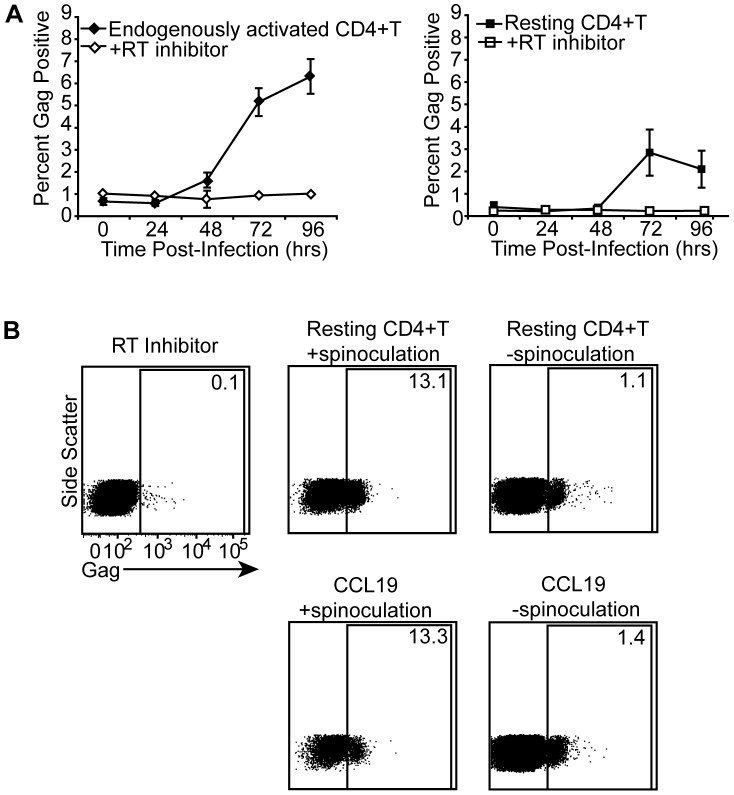
Infected resting CD4+T cells can produce HIV Gag.Bulk unstimulated CD4+T cells were spinoculated and cultured in the presence of the protease inhibitor, saquinavir. Gag protein was measured in the endogenously activated (HLA-DR+, CD25+, or CD69+) and resting (HLA-DR−,CD25−,and CD69−) cells based on activation marker expression at 0, 24, 48, 72, and 96 hours post infection. Control cells were treated with the reverse transcriptase (RT) inhibitor, efavirenz, to establish background protein levels. An average of 3 experiments in 3 different donors is shown (A). In B, purified resting or CCL19 treated cells were infected with HIV with or without spinoculation at 1200×g. Controls and gates were made as in A. Cells were gated on the activation marker negative (HLA-DR−,CD25−,CD69−) population. Approximately 10,000 events were collected for spinoculated samples while approximately 100,000 events were collected for cells that were not spinoculated. Data is a representative of 2 experiments in 2 different donors.